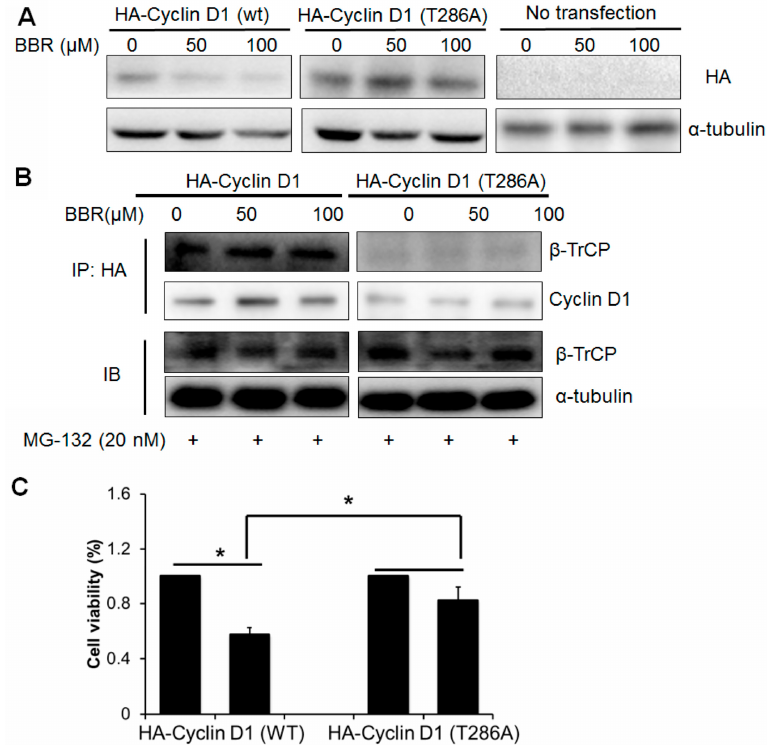
Figure 5. T286 phosphorylation is required from Cyclin D1 ubiquitin-proteasomal degradation induced by berberine. ( A ) Cells expressing HA-tagged wt and mutant Cyclin D1 was treated with berberine for 6 h. Expression of exogenous Cyclin D1 was blotted with hemagglutinin (HA) antibody; ( B ) Cells expressing HA-tagged wt and mutant Cyclin D1 was treated with berberine for 6 h. The protein complex was precipitated with HA antibody and precipitated β -TrCP and Cyclin D1 were detected. INPUT level of β -TrCP was detected as control; ( C ) Cells expressing HA-tagged wt and mutant Cyclin D1 was treated with berberine for 24 h. Cell viability was detected by 3-(4,5-dimethylthiazol-2-yl)-2,5-diphenyltetrazolium bromide (MTT) assay (+ means presence of the chemicals). * p < 0.05.